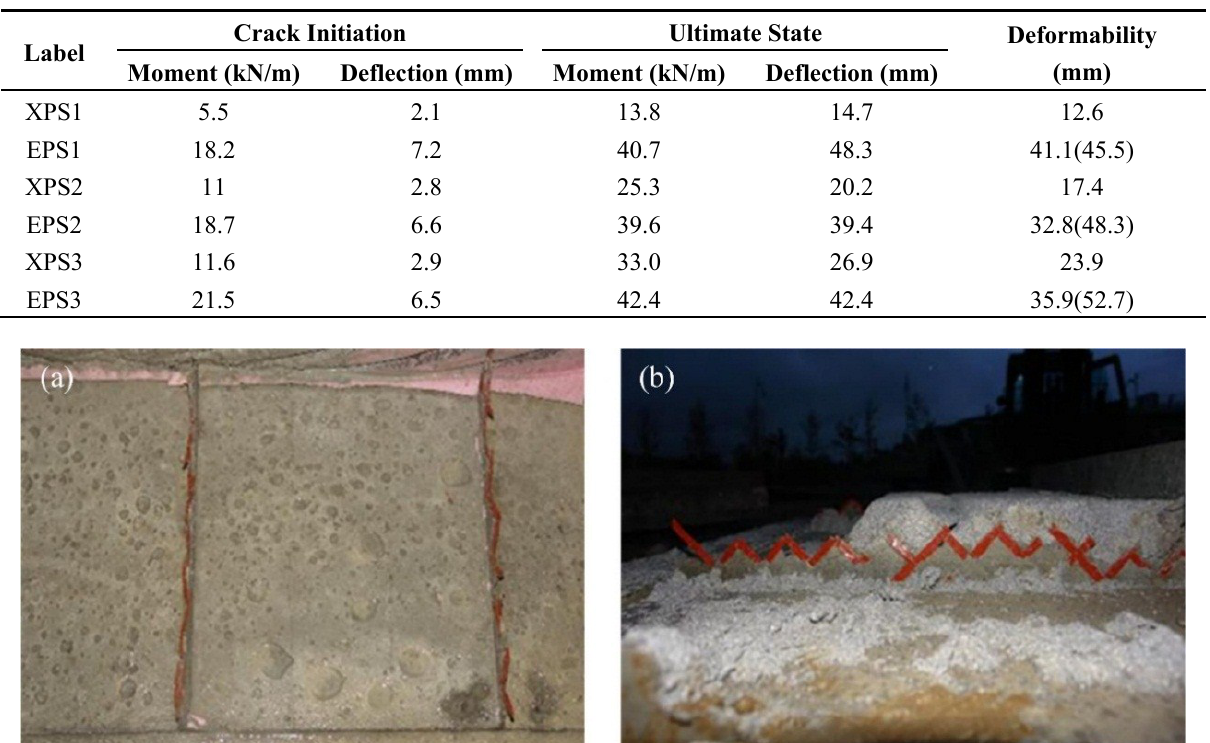
Figure 9. Comparison of the load-deflection curves depending on the insulation type. Table 4. Comparison of the moment and deformation capacities.